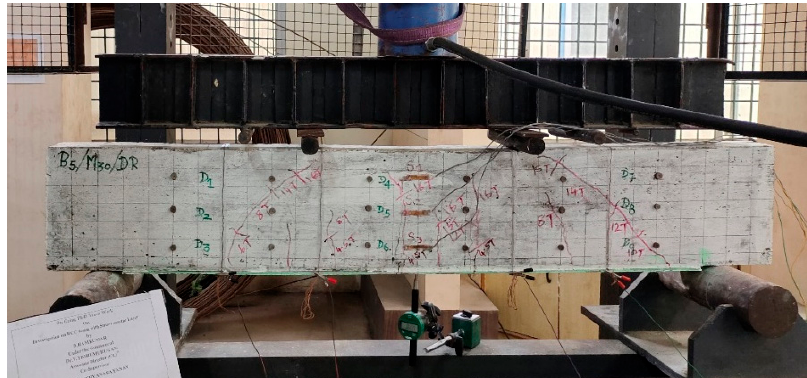
Figure 5. Crack pa tt erns of the reinforced concrete beam with smart mortar layer. Figure 5. Crack patterns of the reinforced concrete beam with smart mortar layer.